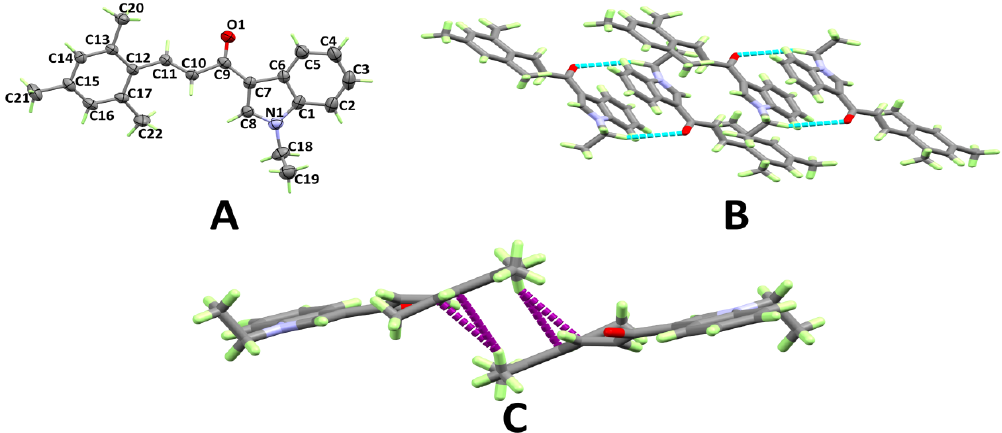
Figure 4. Atom numbering and thermal ellipsoids drawn at 30% probability level ( A ), hydrogen bonds ( B ), and C–H··· π ( C ) stacking interactions in 3d .